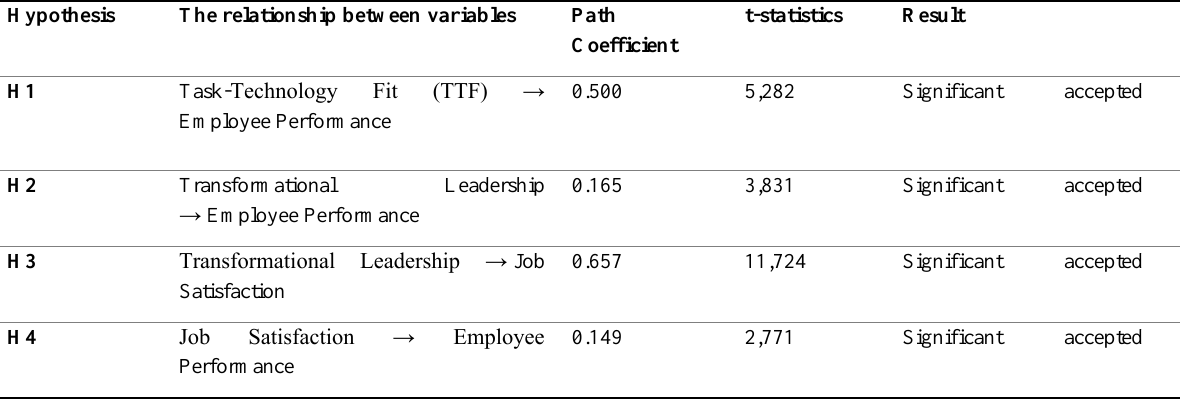
Table 4: Hypotheses Summary